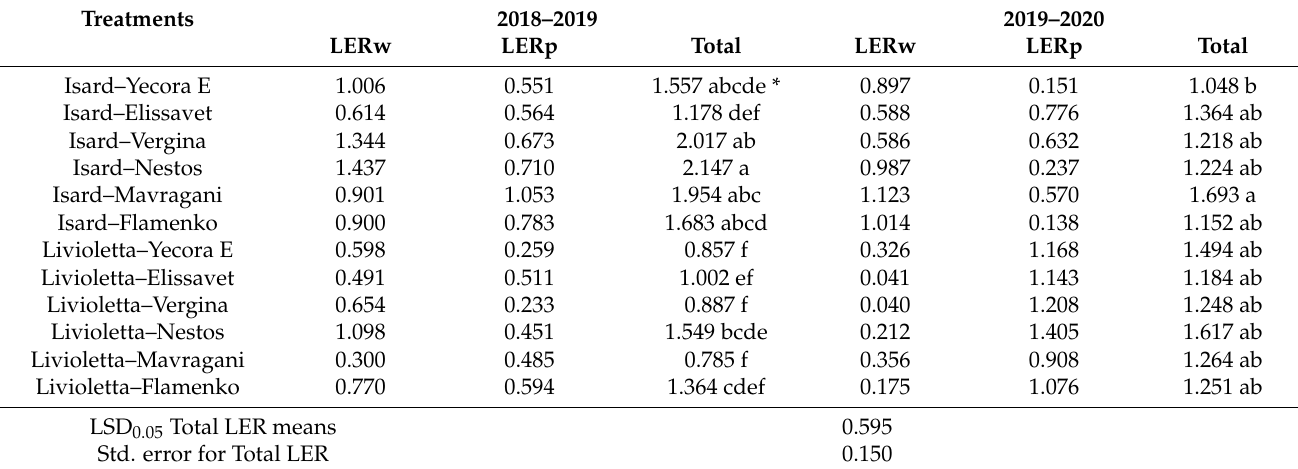
Table 4. Land equivalent ratio of wheat (LER w ), pea (LER p ), and total land equivalent ratio (LER) of the different intercropping